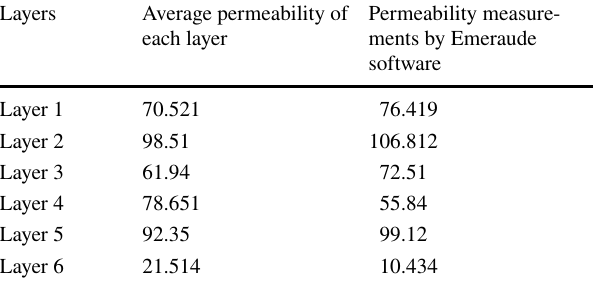
Table 6 Comparison of permeability between two techniques after correcting core data analysis Layers